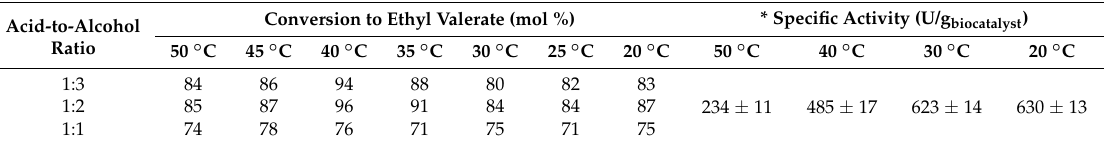
Table 4. Effect of reaction temperature on the conversion of valeric acid to ethyl valerate and specific activity of biocatalysts after